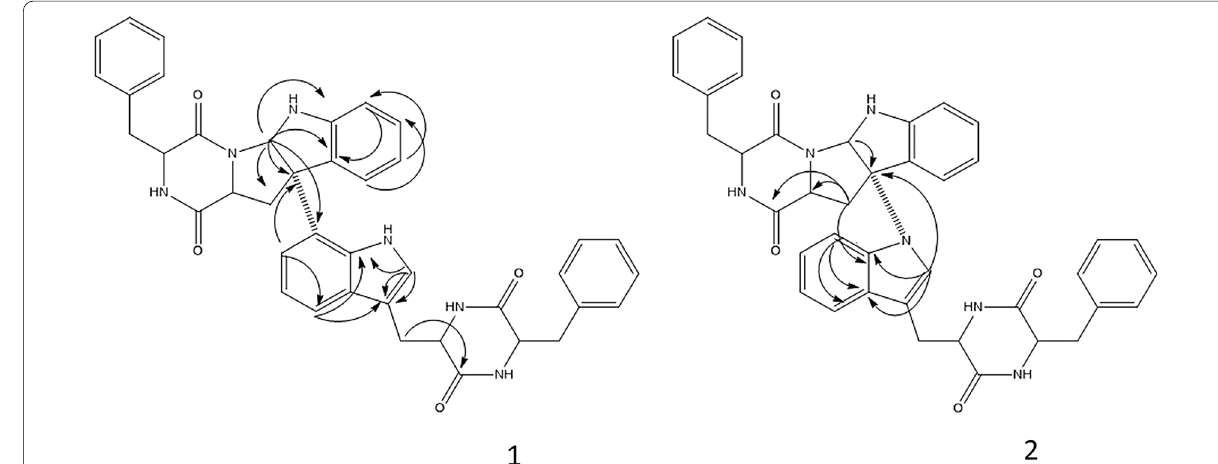
Fig. 2 HMBC correlations of asperazine (1) and asperazine A (2)